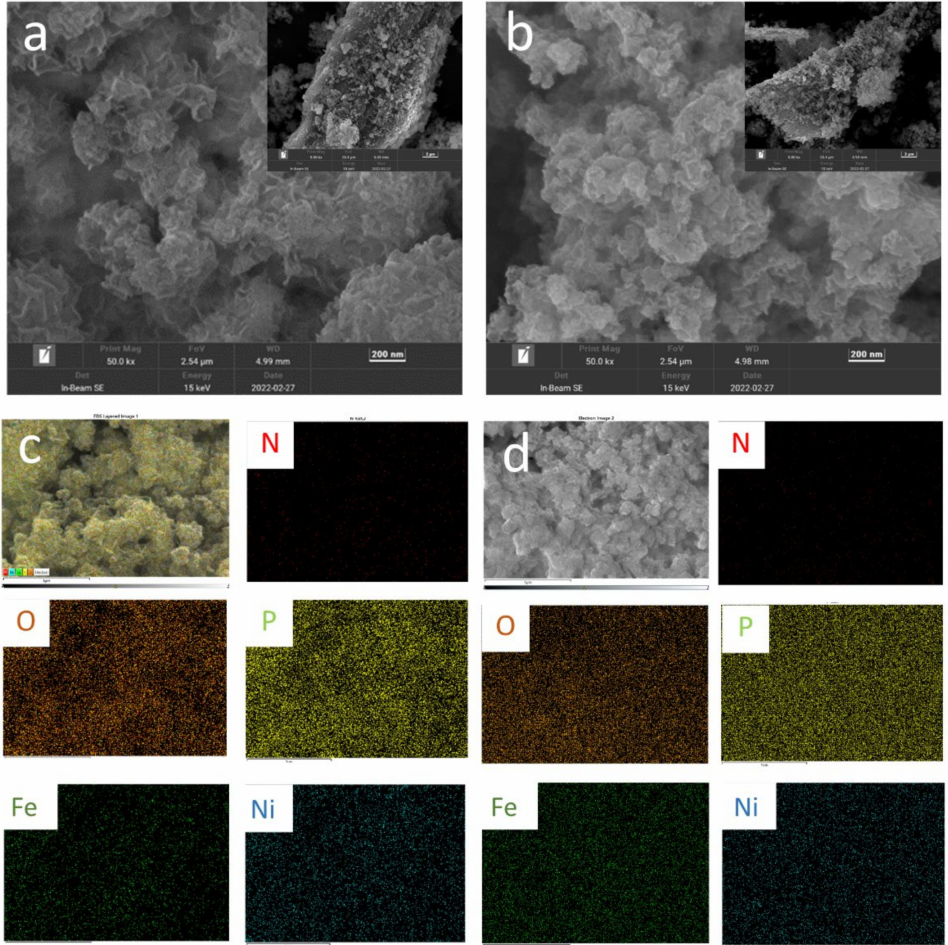
Figure 2. (( a , b ), inset shows low magnification) SEM images and ( c , d ) elements mapping of N-B-Ni 7 Fe 3 P/SEP and N-B-Ni 7 Fe 3